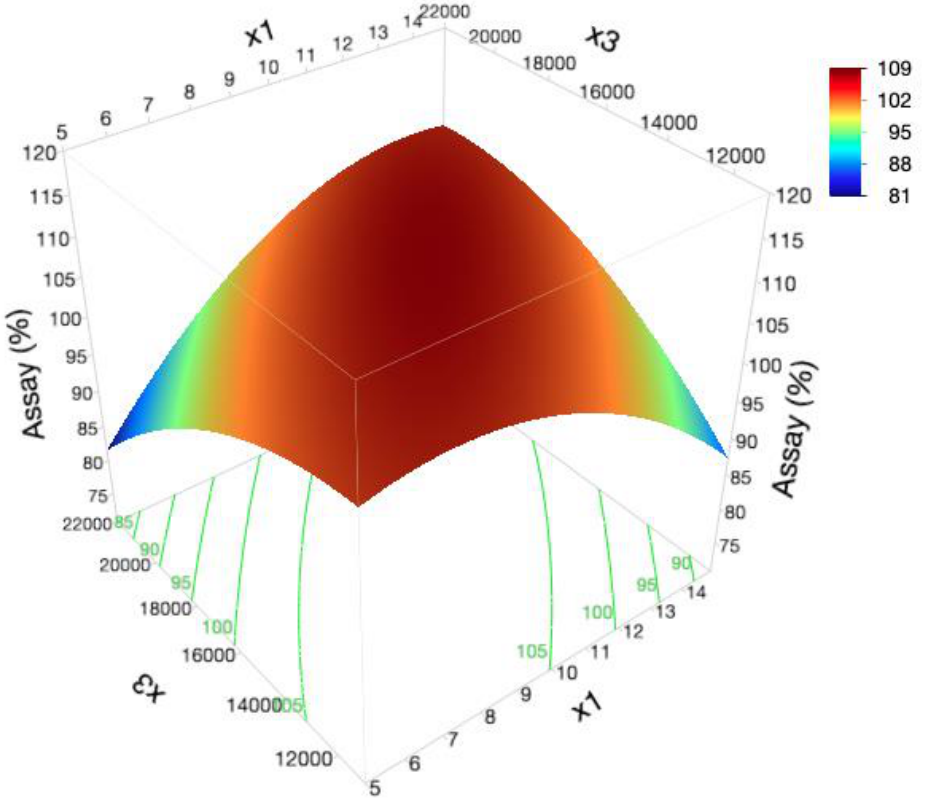
Figure7. Responsesurfaceplotshowingthee ff ectofglycerolmonostearateamountandhomogenization Figure 7. Response surface plot showing the effect of glycerol monostearate amount and rate interaction on assay homogenization rate interaction on assay response.